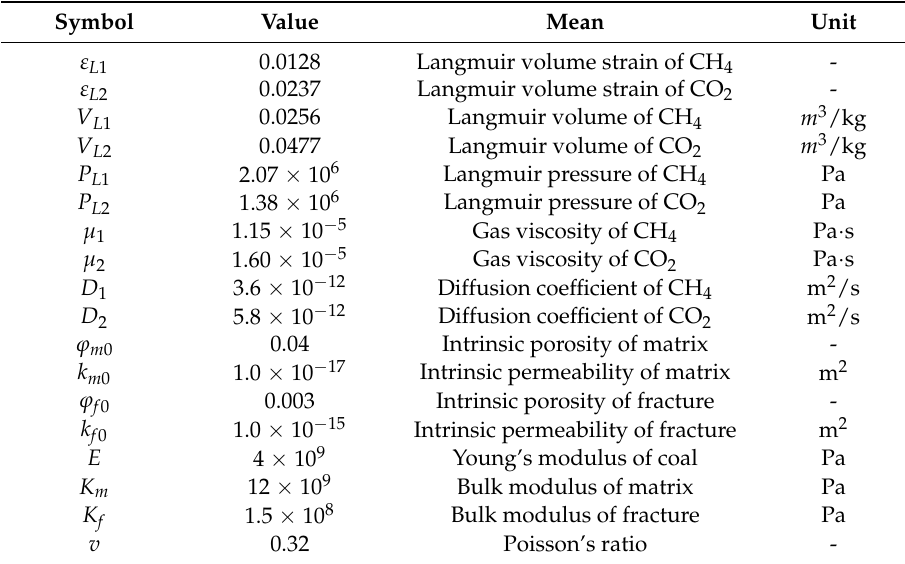
Figure 3. The situations of a CBM reservoir and the simulation model used in this study: ( left ) the production area which shows a regular five-spot pattern CBM reservoir with the IW in the center and the PW in the four corners of the square; and ( right ) the simulation area which shows boundary condition and meshing situation of one-quarter (top right corner) of the CBM reservoir. Table 1. Main input parameters for the simulation model.